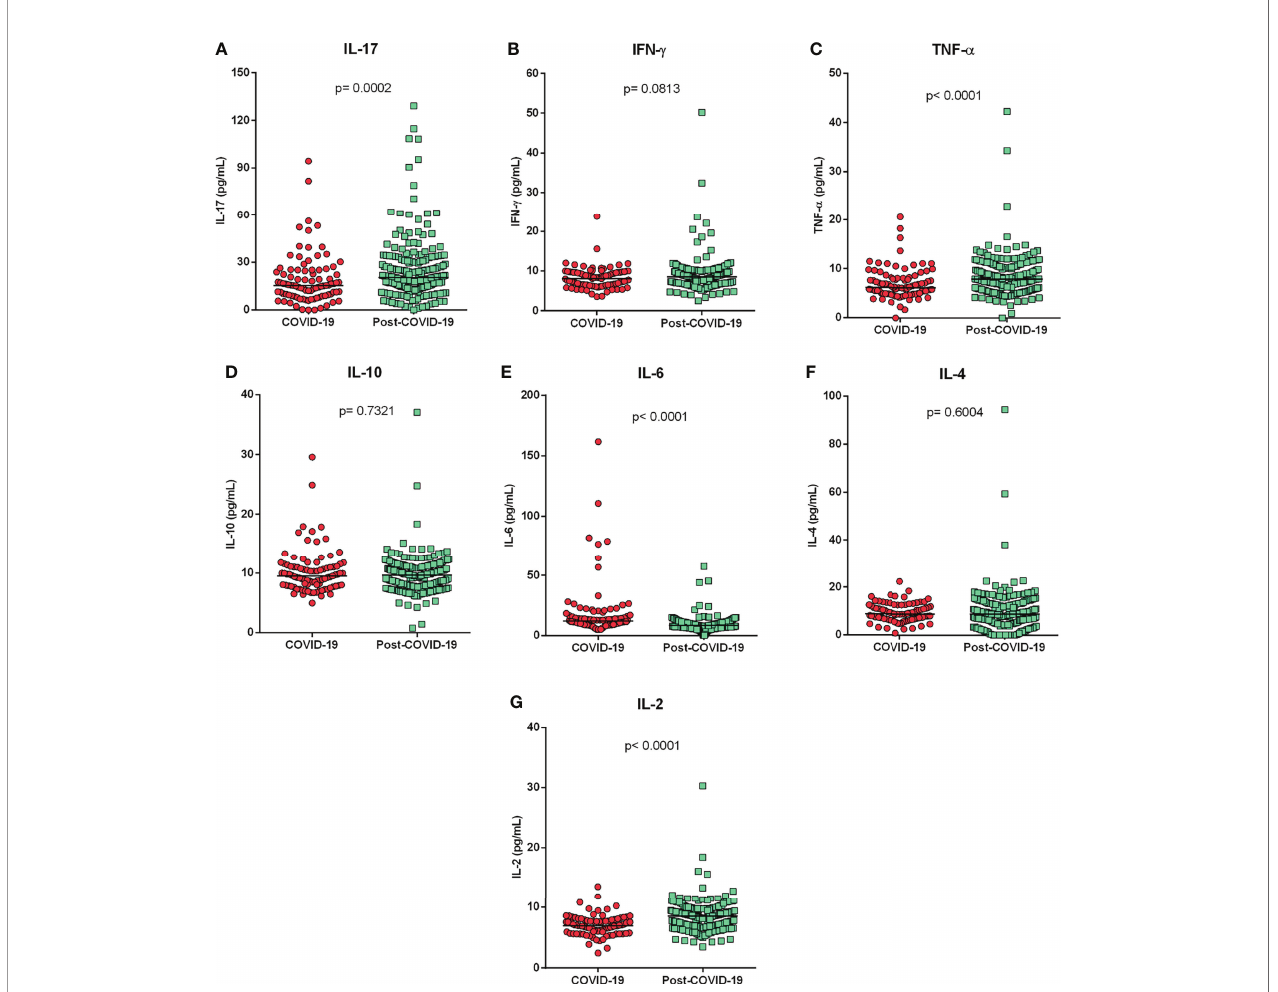
FIGURE 1 | Cytokine levels according to different clinical manifestations of COVID-19. Comparison of cytokine levels (A) IL-17, (B) IFN-y, (C) TNF-a, (D) IL-10, (E) IL-6, (F) IL-4 and (G) IL-2, between patients with acute COVID-19 and individuals in the post-COVID-19 period. Mann-Whitney